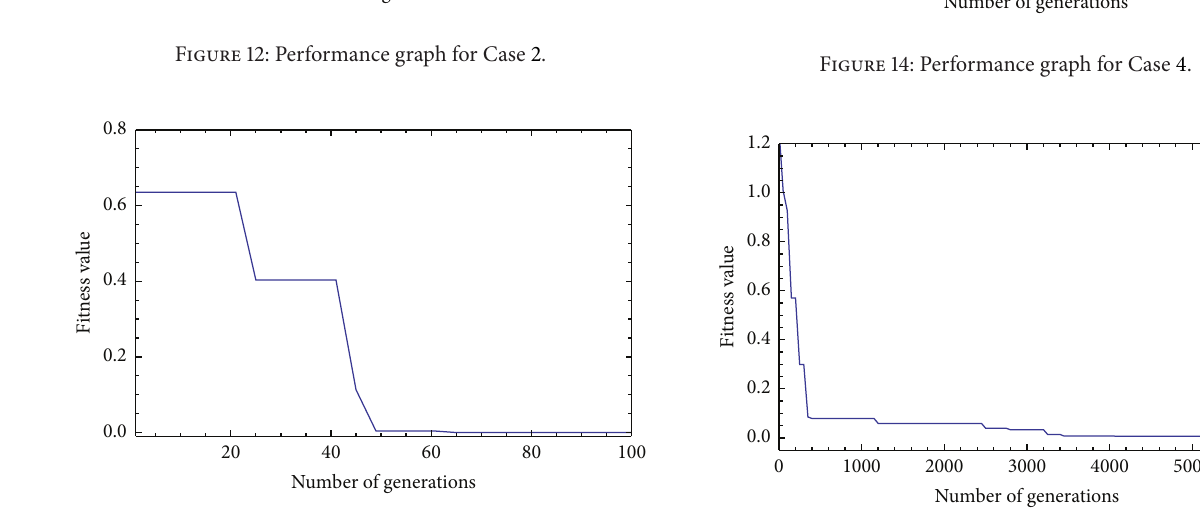
Figure 13: Performance graph for Case 3.